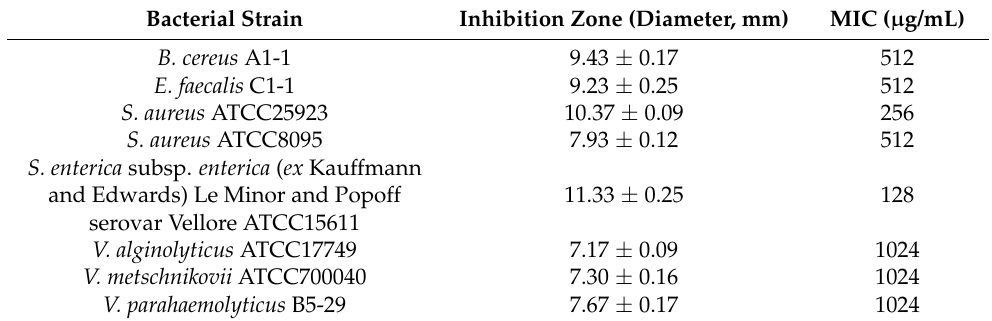
Table 2. Antibacterial activity of Fragment 1 of the methanol-phase extract from C. communis Linn.